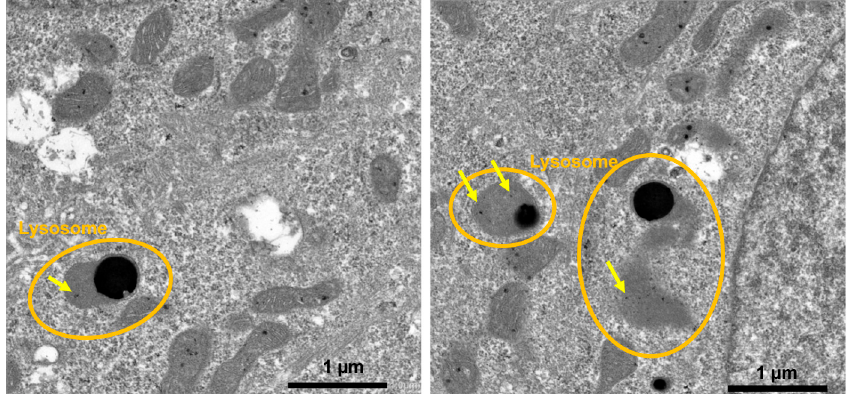
Figure 4. Transmission electron microscopy (TEM) images showing nanoparticles (PCSNs, yellow arrows), confirming that the probes are inside the cells. Some of the silica nanoparticles are found within lysosomes.